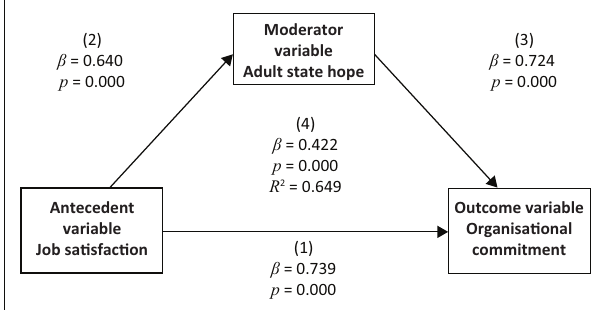
FIGURE 2: Mediation analysis between job satisfaction, adult state hope and organisational commitment.